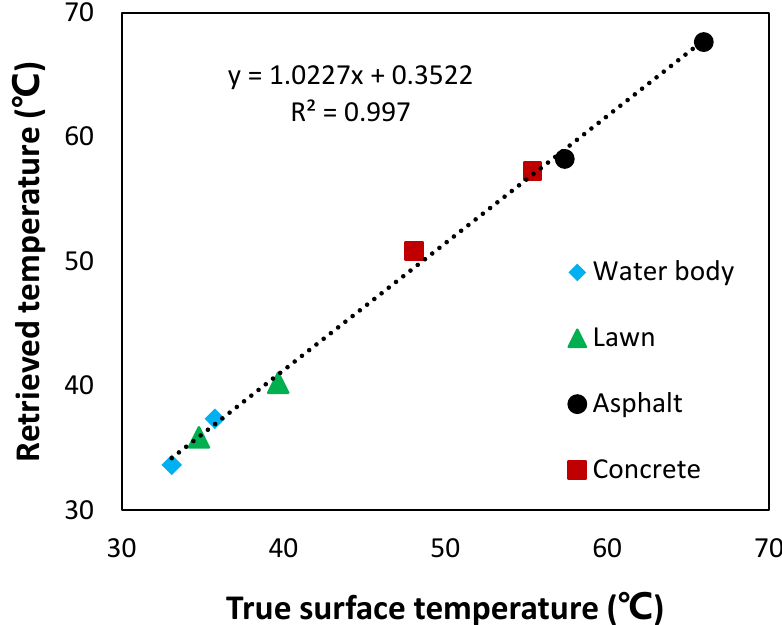
Figure 10. Correlation between retrieved LSTs and ground true